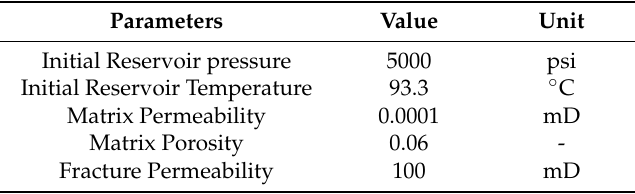
Figure 6. Field scale simulation model in ij view. Table 2. Reservoir and fluid characteristics.